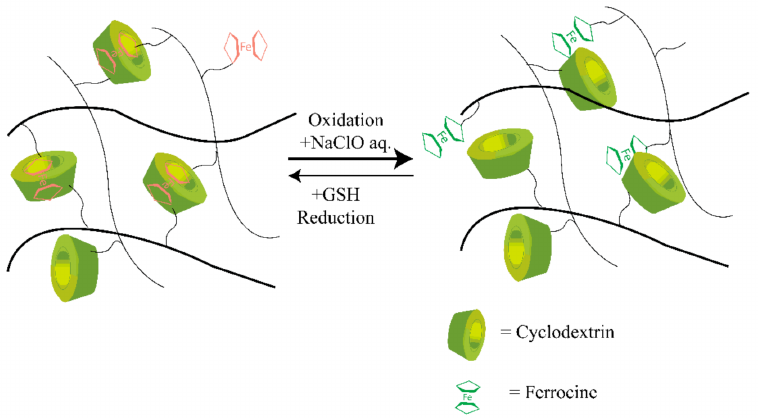
Figure 3. Illustration of the mechanism of host–guest interaction-based redox-active SHH. CD undergoes host-guest interaction with Fe ions through redox phenomena and which results in the self-healing properties. Self-healing hydrogel: SHH; cyclodextrin: CD. CDs undergo the desired bonding with the ferrocene molecules marked as the red color, while on the right side, host–guest bonds are broken in the presence of an oxidizing agent.